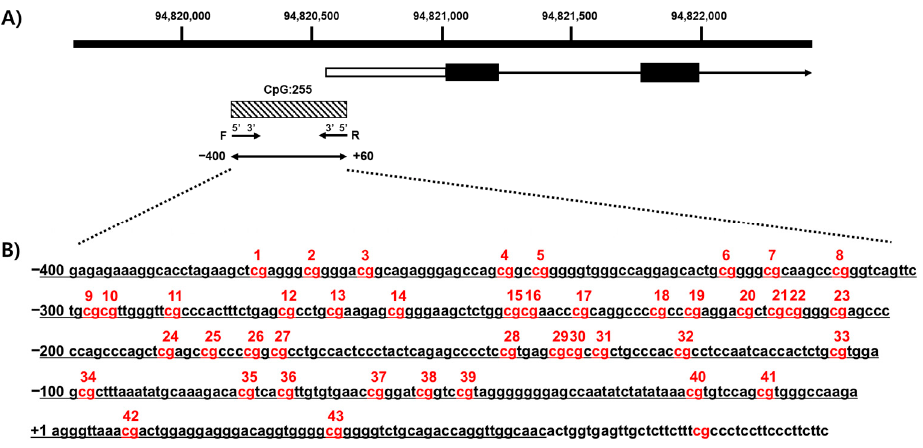
Figure 1. Analysis of methylation of CpG sites in the CYP26C1 promoter region. ( A ) The black box and arrow show CYP26C1, and the shaded box indicates the CpG island region located in the 5 ′ -flanking region of CYP26C1. ( B ) The sequence of the CYP26C1 promoter region. The underline in- dicates the positions of DNA methylation. The CpG sites analyzed in this study are numbered. Red: DNA methylation of CpG sites.